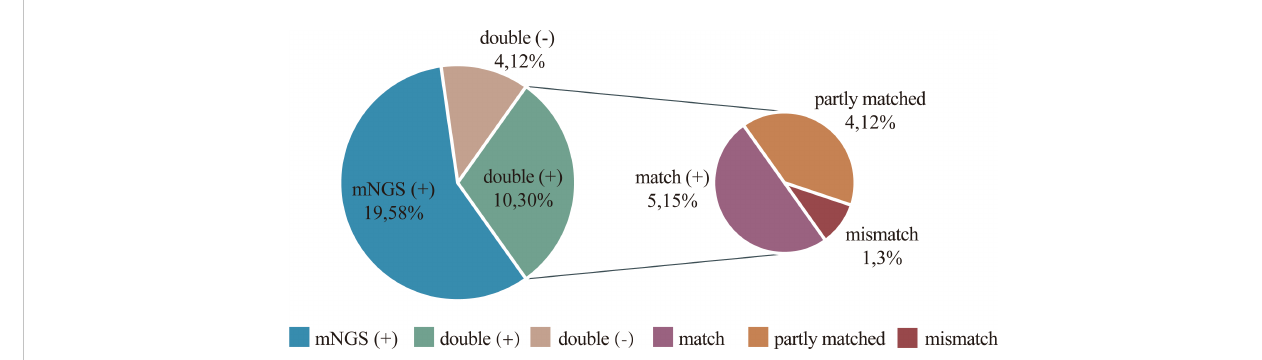
FIGURE 4 Concordance between mNGS and culture in detection of pathogen. The pie chart demonstrating the positivity distribution for detection of pathogen by two tests in 33 cases. mNGS is more advantageous in detecting pathogens. 19 (58%) cases had pathogens detected by mNGS only. For the double- positive subset, 4 cases were found to be partly matched, meaning that at least one pathogen identi fi ed in the test was con fi rmed by the other.